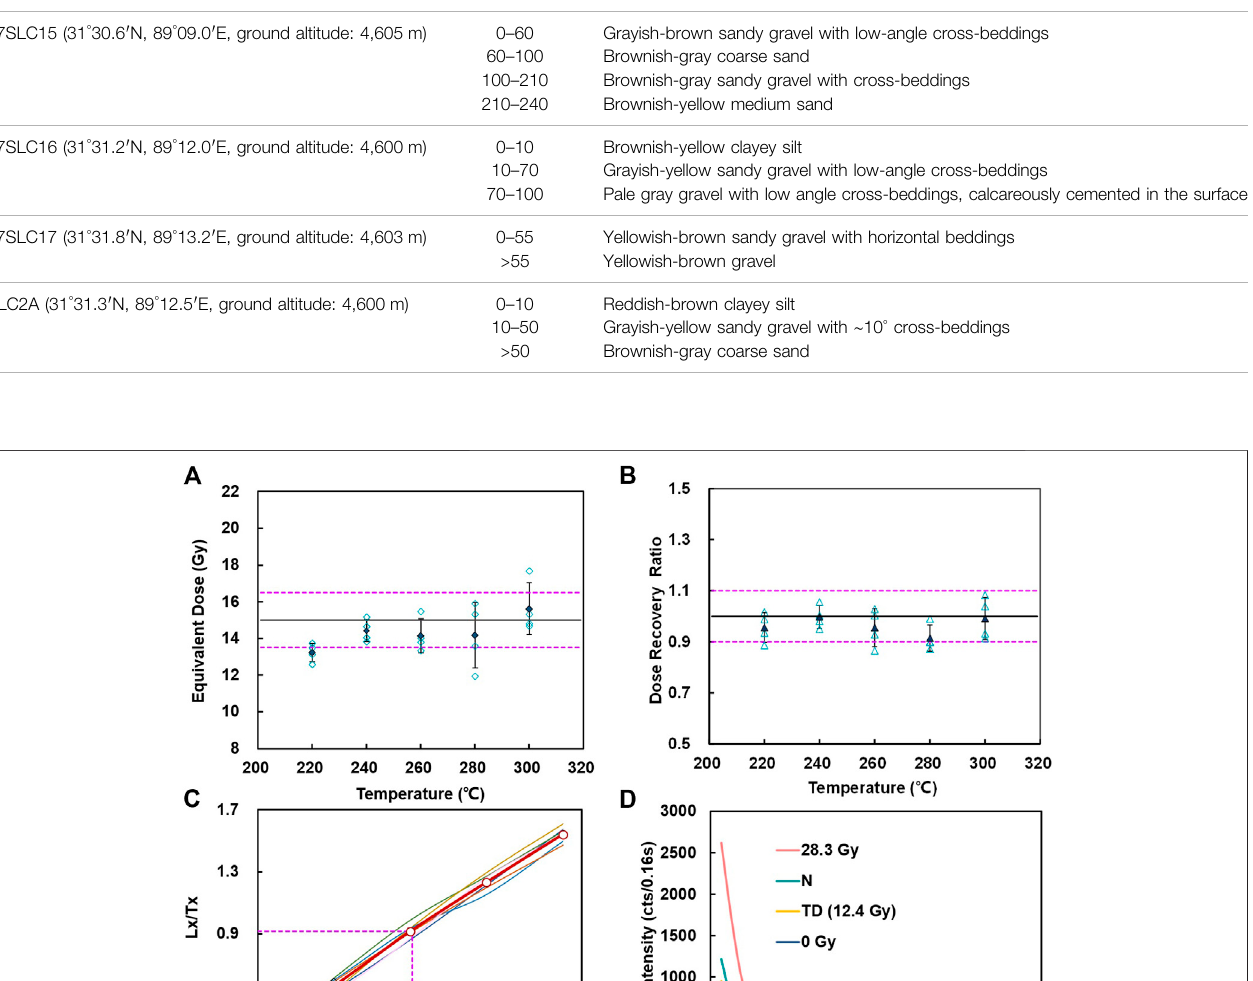
TABLE 1 | Lithological details of studied sections from the paleo-shoreline at ∼ 4,600 masl. Section